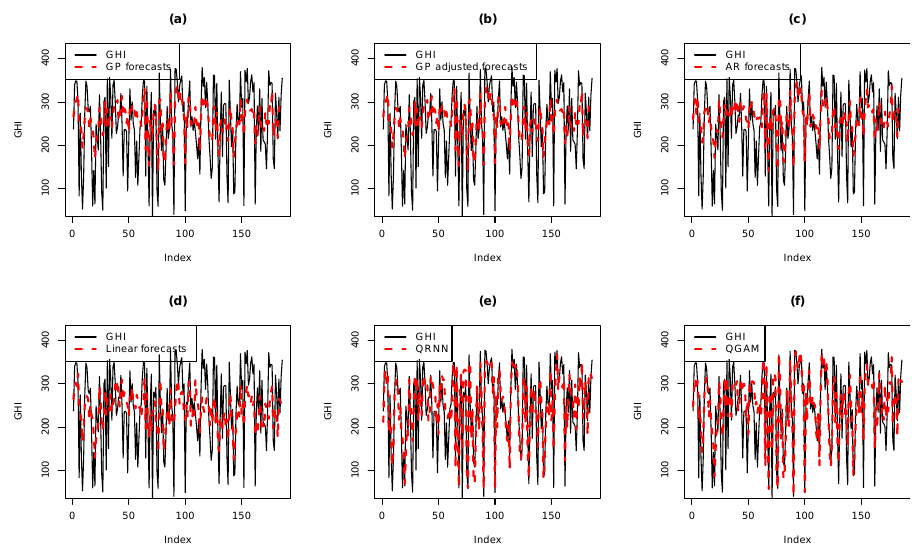
Figure 11. Plots of GHI with forecasts from ( a ) GP, ( b ) GP adjusted ( c ), AR ( d ) Linear models and combined forecasts using ( e ) MCQRNN and ( f )